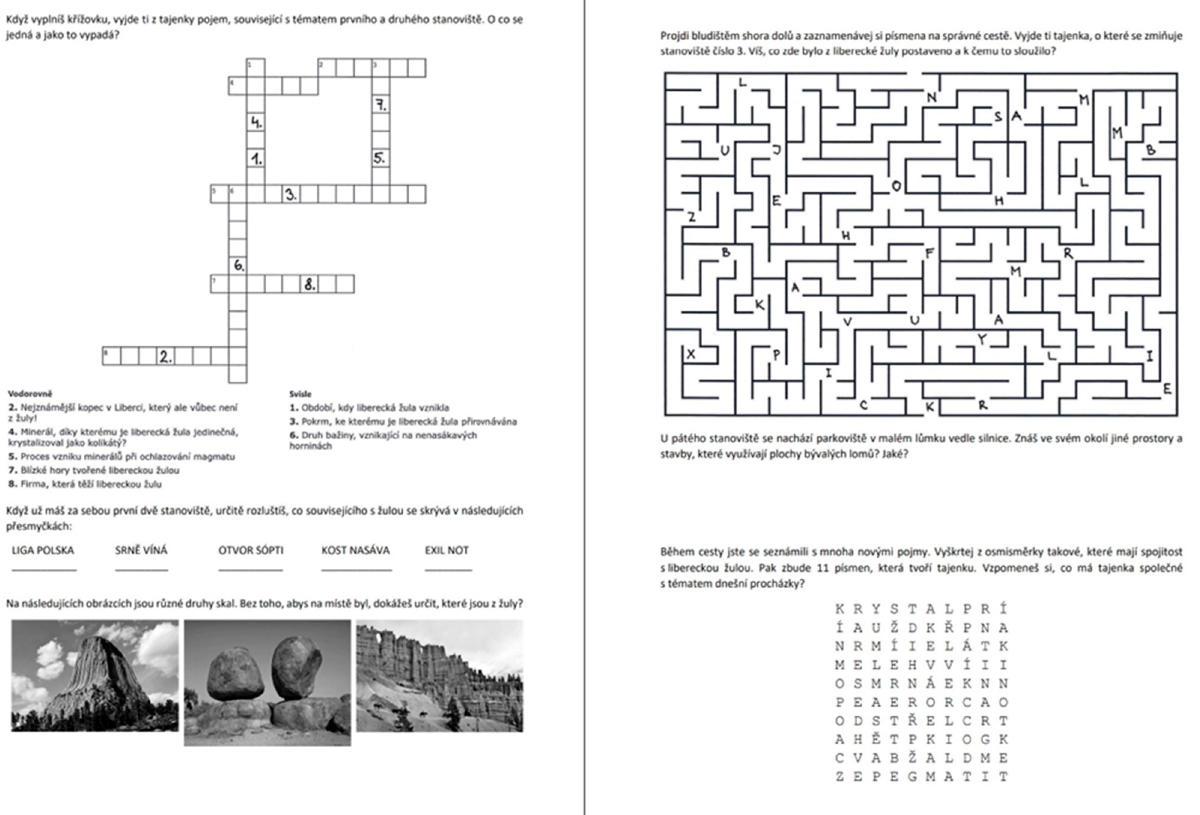
Figure 6. Example of a geotrail worksheet—front and back of worksheet for Primary 2 (age 11–15). Translation of task assignments: When you complete the crossword puzzle, a term related to the topic of the first and second stations will come out. What is it, and what does it look like? Once you’ve completed the first two locations, you’ll surely decipher what granite-related things are hid- den in the following gimmicks: The following pictures show different types of rocks. Without being there, can you tell which ones are made of granite? Go through the maze from top to bottom and